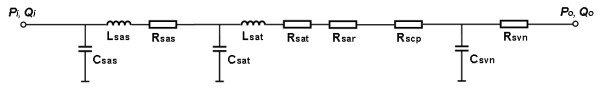
A sample multi-compartment model. (sas: aortic root; sat: artery; sar: arteriole; scp: capillary; svn: vein).